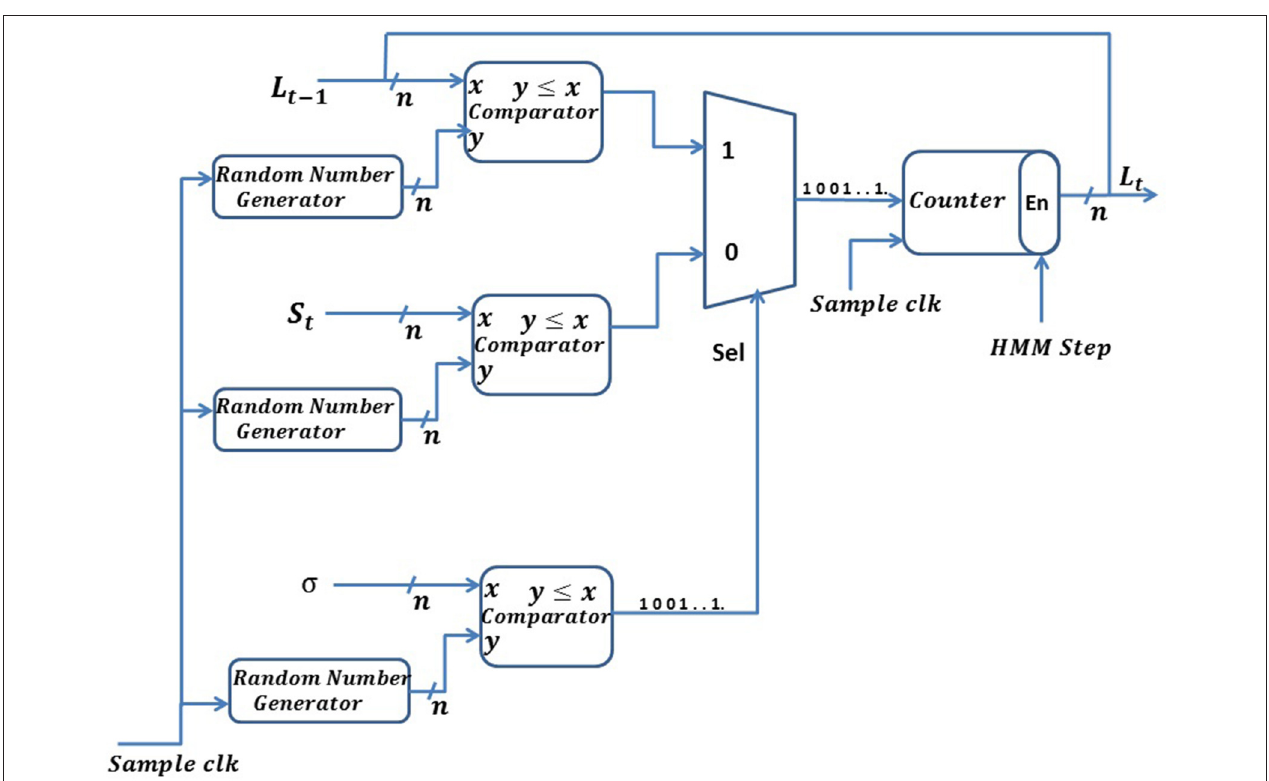
FIGURE 7 | Schematic of the stochastic exponential moving average (SEMA)